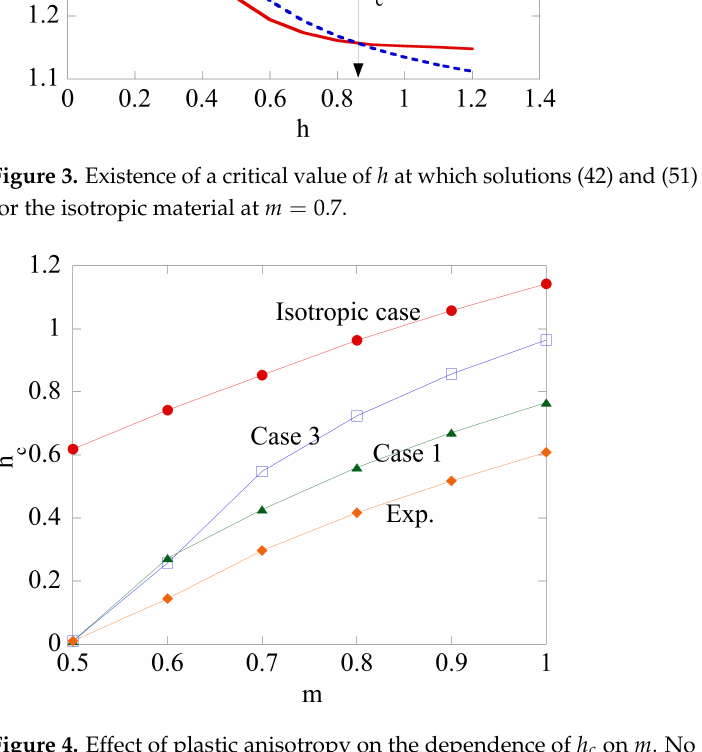
Figure 4. Effect of plastic anisotropy on the dependence of h c on m . No h c is found for Case 2 since ( 1 ) < p ( 2 ) p u u in the m